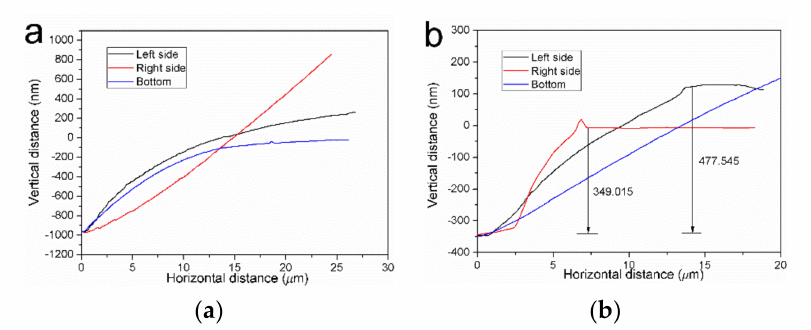
Figure 8. Height profile images of etch pit ( a ) and triangular pit ( b ) measured by